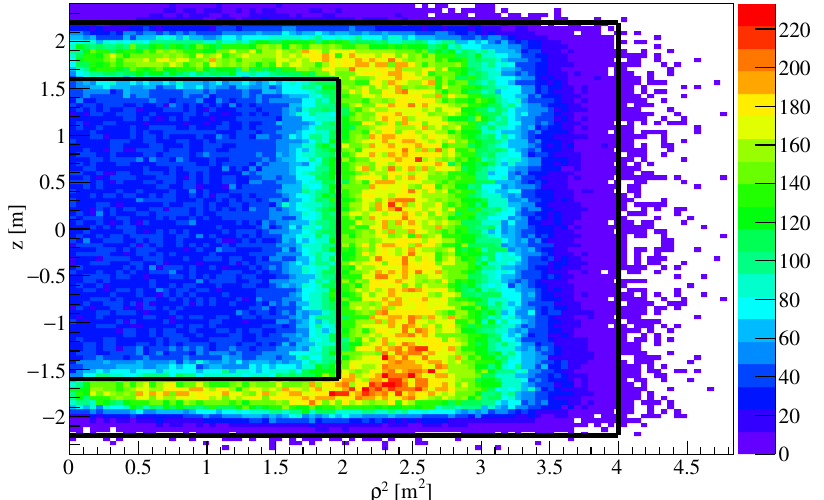
Figure 3 . Vertex distribution of n-H IBD events in the height ( z ) and radius ( (cid:26) ) plane. The number of reconstructed IBD events are represented by color. The inner (outer) solid line represents the target (GC) boundary. Neutrons are mostly captured by Gd in the target where the n-H delayed candidates are much fewer than in the GC. The bu(cid:11)er surrounding the GC is (cid:12)lled with non- scintillating mineral oil and expects no events in the